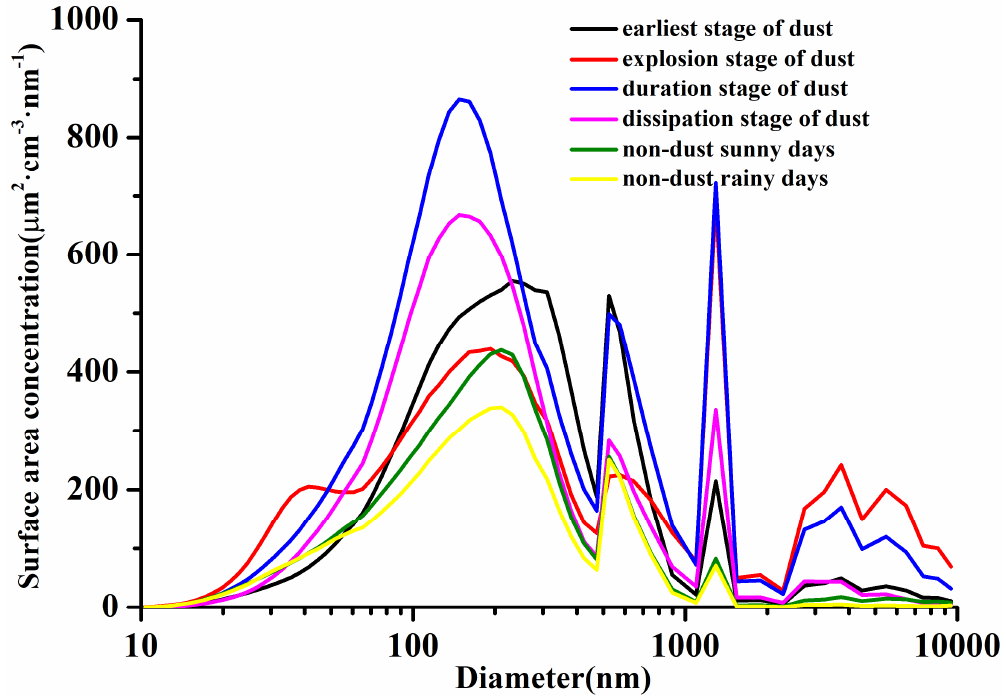
Figure 7. Size distribution of aerosol surface area concentrations during the different dust stages.